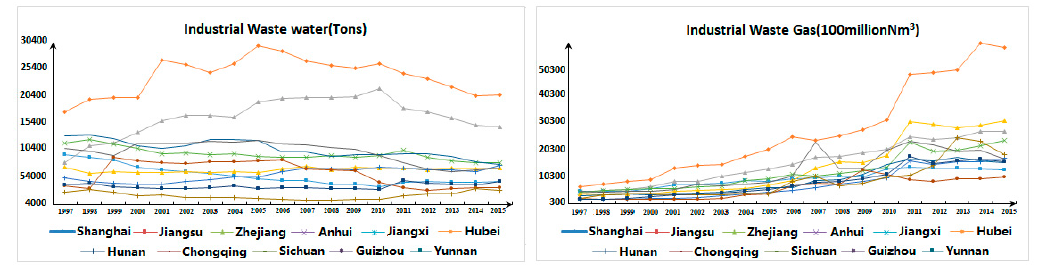
Figure 4. Industrial Undesirable Output Diagram of Yangtze River Economic Belt.